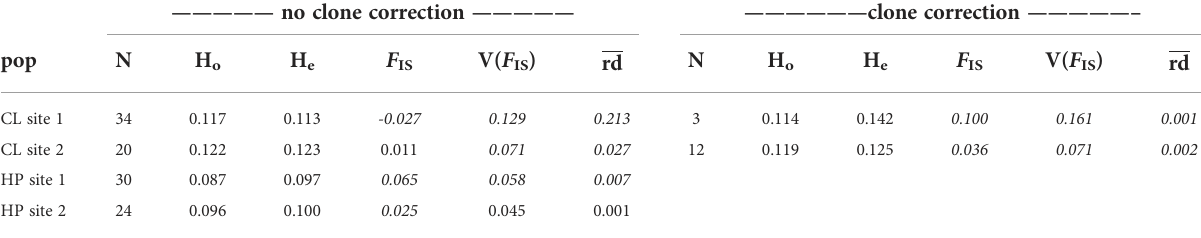
TABLE 1 Genetic diversity within Hamelin Bay populations of Ecklonia radiata before and after clone